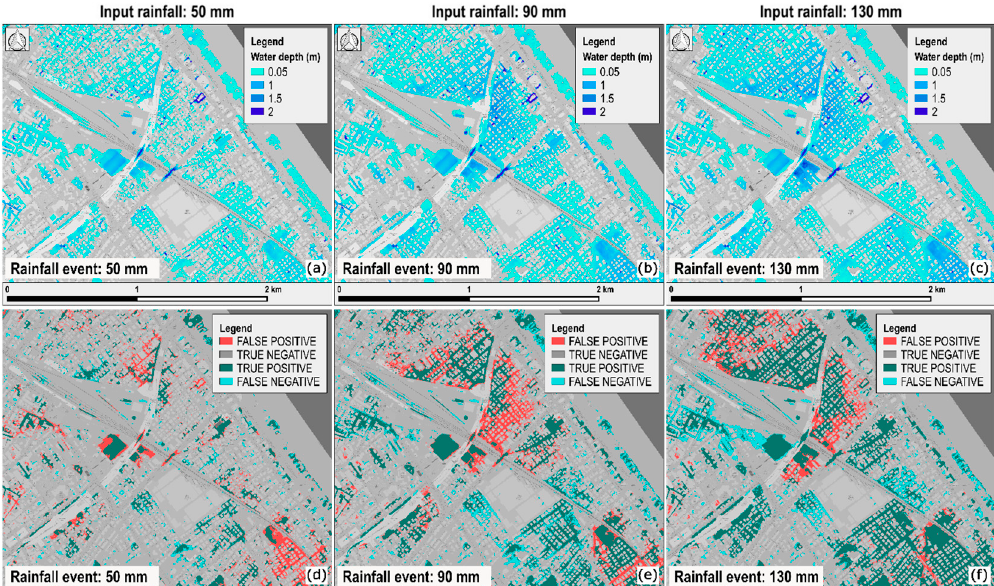
Figure 8. Rimini case study: flooding phase output. ( a – c ) Water depth maps obtained under the assumptions of spatially uniform rainfall and impervious terrain and relative to three different synthetic rainfall depths (color-scale represents water depth values). ( d – f ) Comparison between Safer_RAIN and Hydro_AS-2D outputs: images report a classification of pixels into false positive (FP), true positive (TP), false negative (FN), and true negative (TN). Table 1. Safer_RAIN performances obtained by comparing the obtained flood hazard maps with the benchmarking maps (2D-hydrologic-hydrodynamic maps) for several rainfall scenarios.